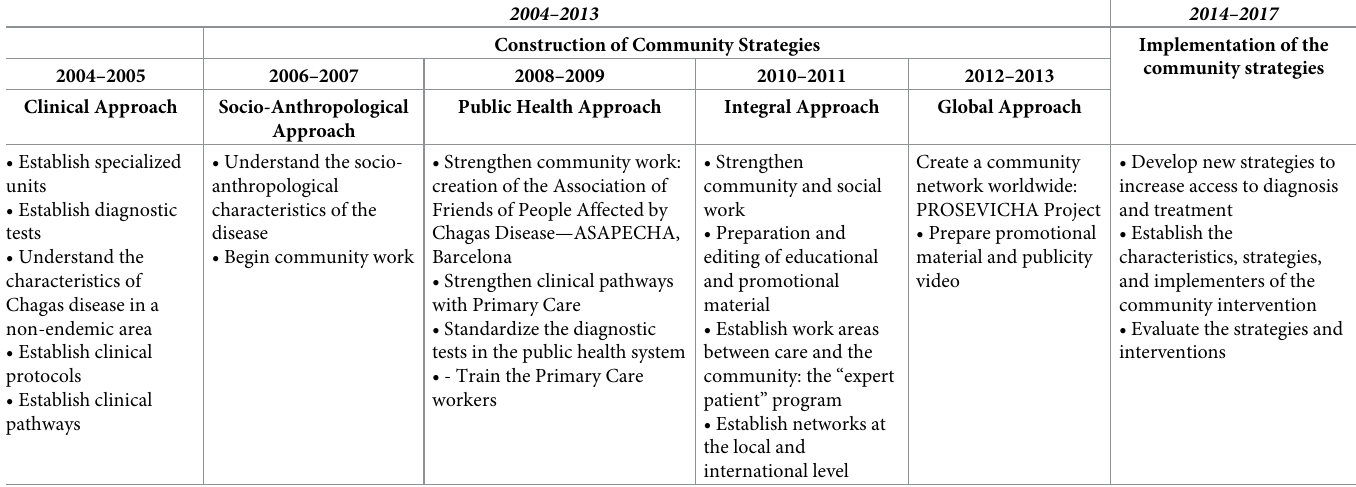
Table 1. Stages of the construction and implementation process of the community strategies for improvement of access to diagnosis and treatment of Chagas disease in Catalonia: Approaches and